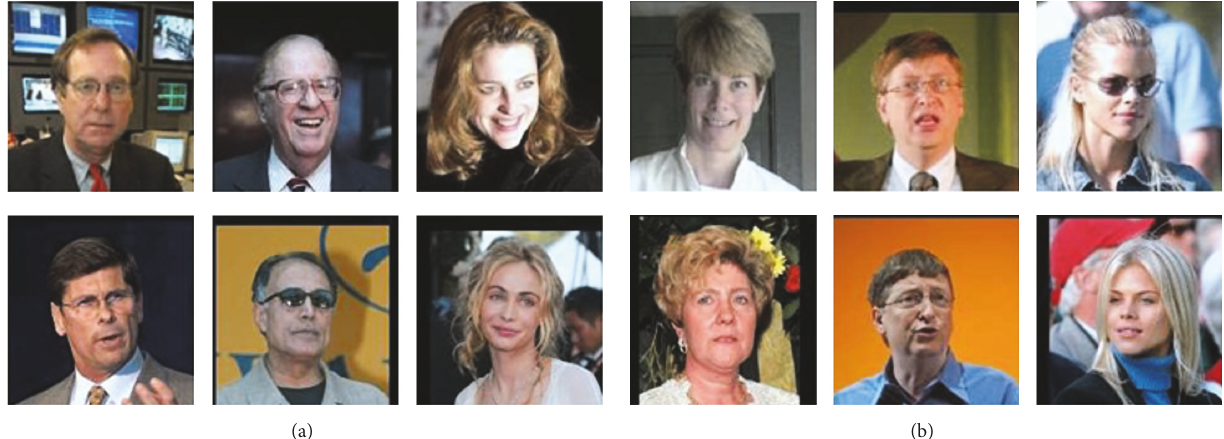
Figure 1: Confusing face pairs selected from LFW [25]. (a) shows images from different people, while (b) shows the opposite